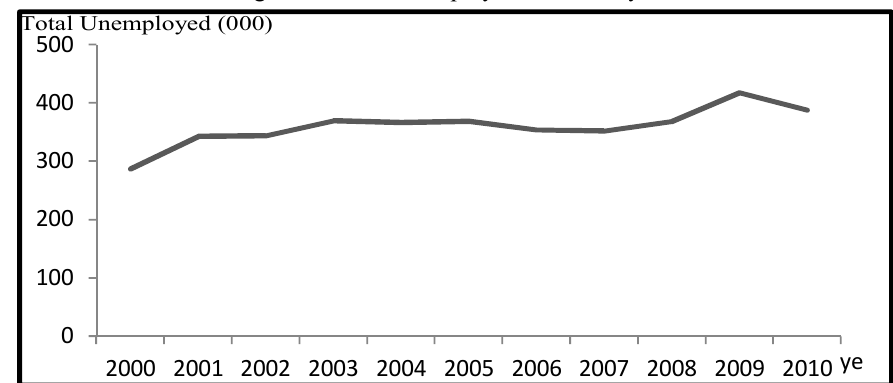
Figure 1: Total Unemployment in Malaysia.